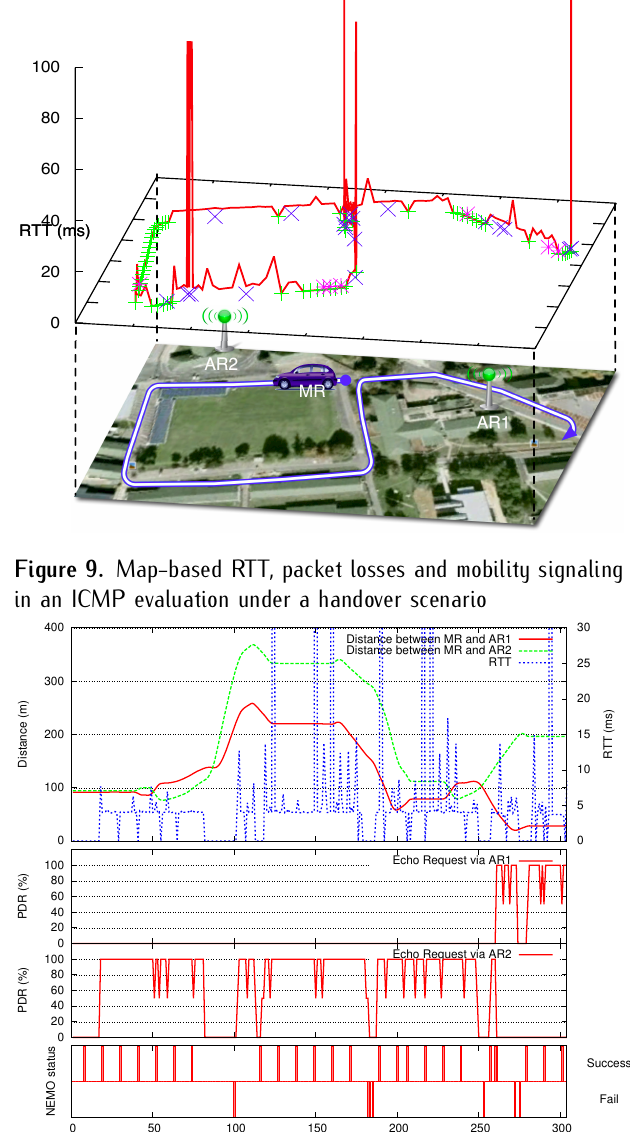
end of this part of the circuit, as can be seen with the three consecutive binding registration fails. When the MR fails to receive a valid matching response within the selected initial retransmission interval, the MR should retransmit the message until a response is received. The retransmission by the MR must use an exponential back-o ff in which the timeout period is doubled upon each retransmission, until either the MR receives